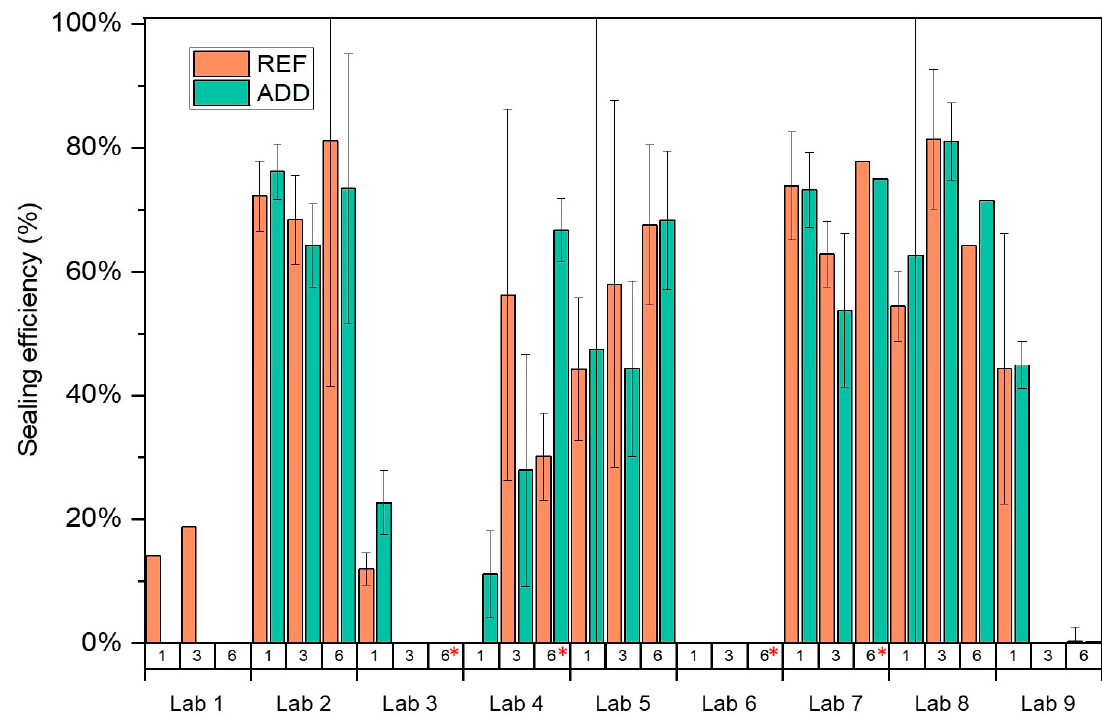
Figure 13. Sealing efficiency (SE) based on capillary water absorption measured in the different labs. * denotes a longer